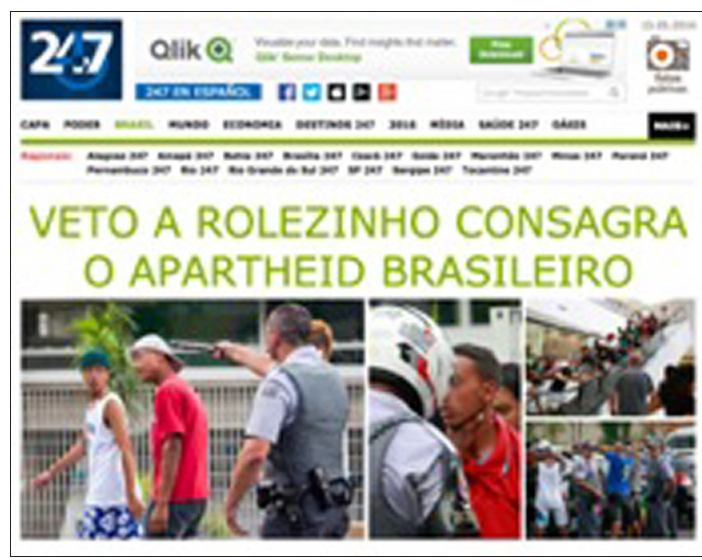
Figure 2: Brasil 247’s coverage of the ‘rolezinhos’